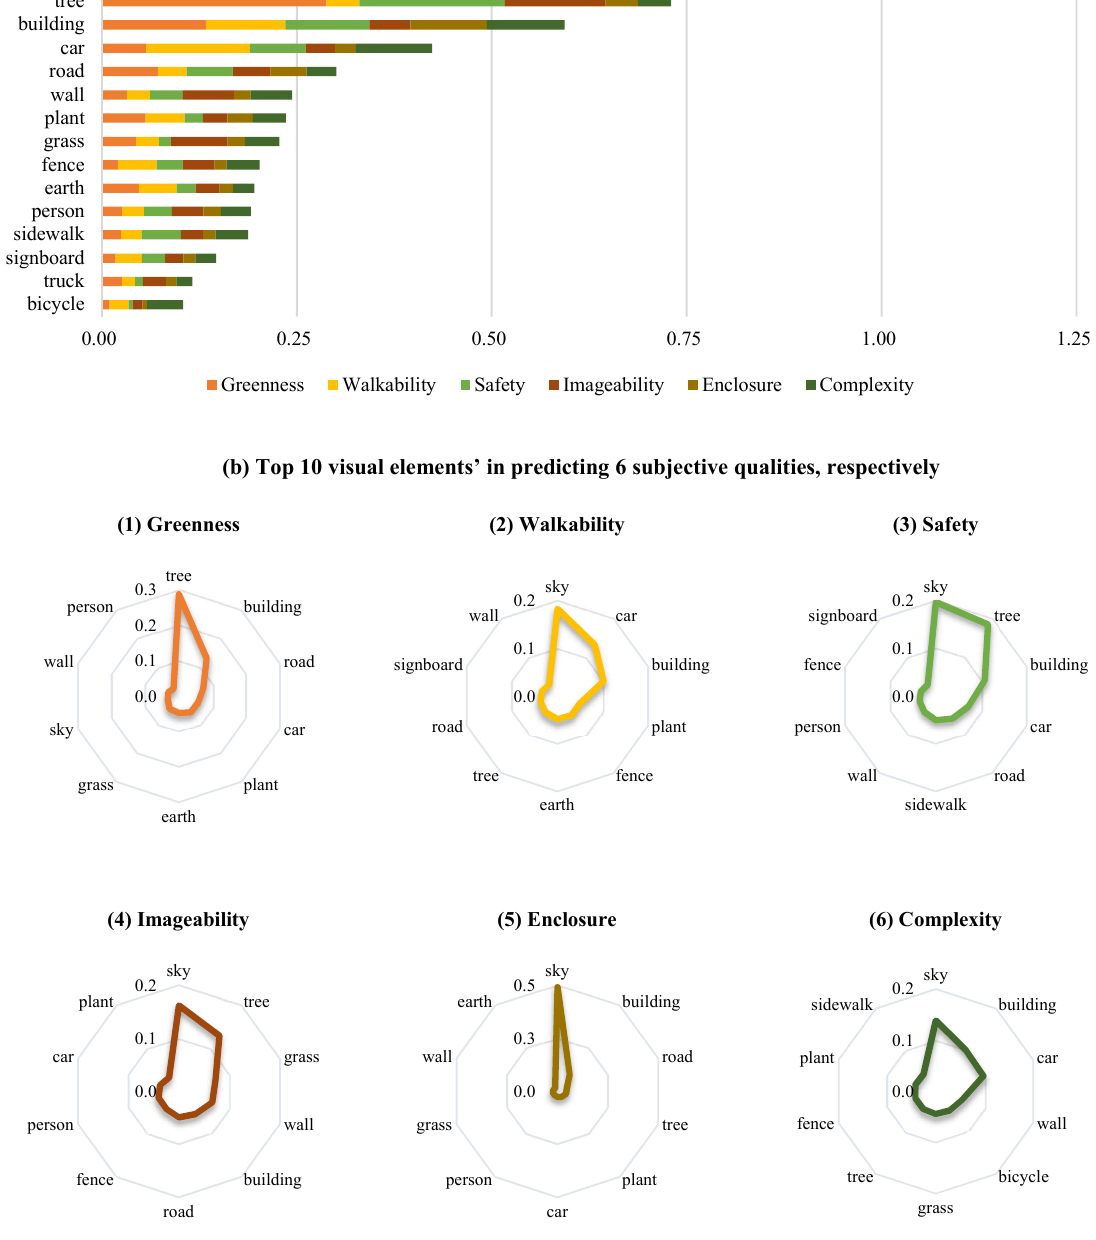
Figure 7. Important features in predicting six subjective scores. ( a ) Top 15 physical features for each subjective score and their sum importance. ( b ) Top 10 important visual elements in predicting each subjective score, respectively.